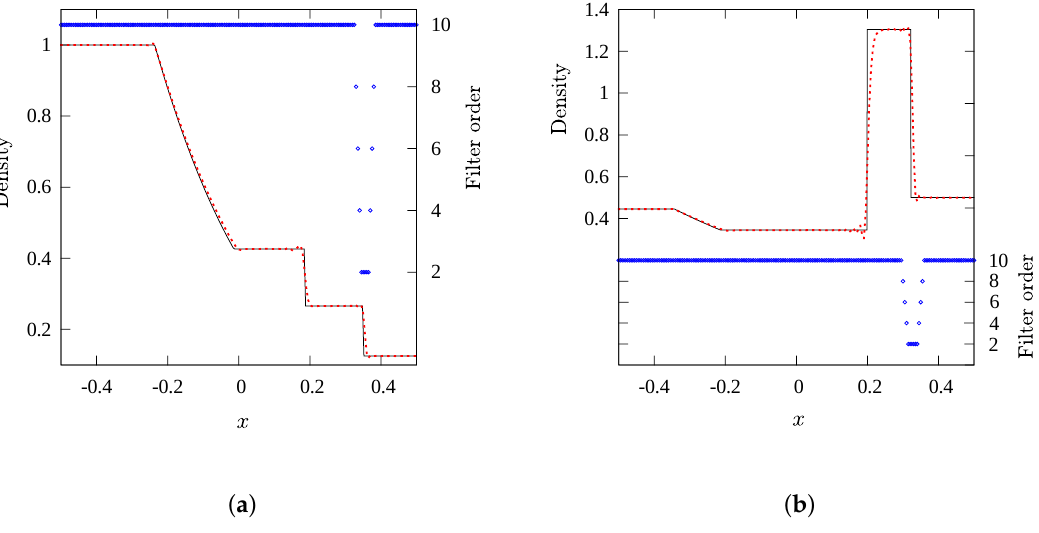
Figure 4. Solution of shock tube problems. exact (——), numerical (– – –), filter order ( • ); α f ( F 2 ) = 0.47, α f ( F 4 ) = 0.48 and α f ( F 6, F 8, F 10 ) = 0.498. ( a ) Sod’s problem at t = 0.2; and ( b ) Lax’s problem at t =